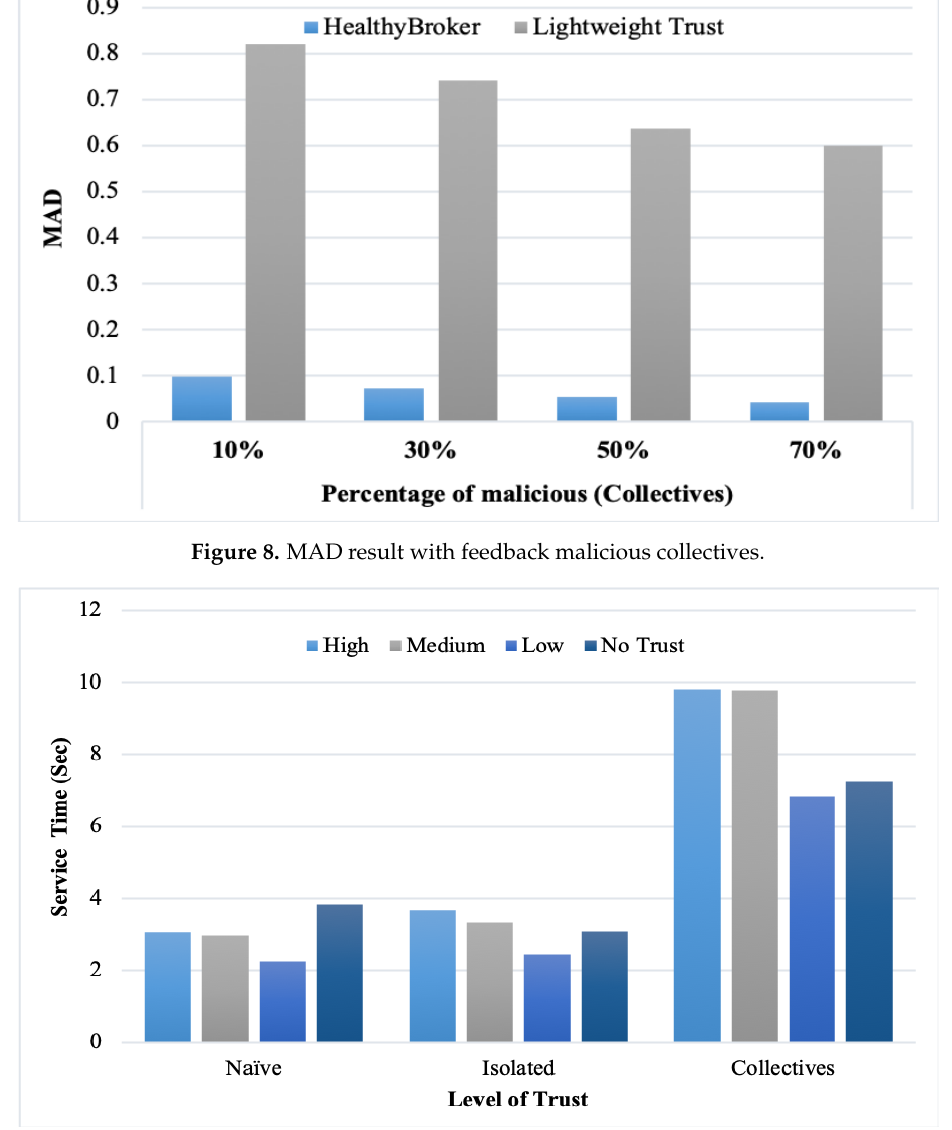
Figure 9. Service time with 70% of malicious.